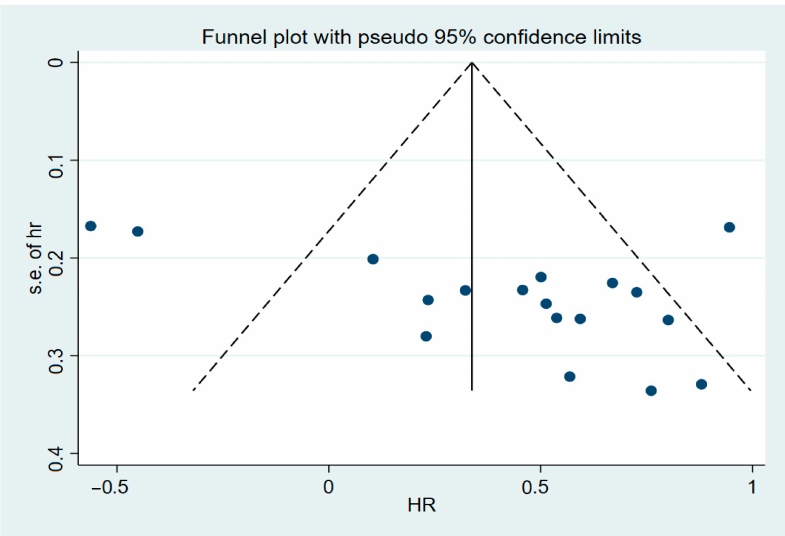
Publication bias detection for included studies (funnel plot). Figure A1.